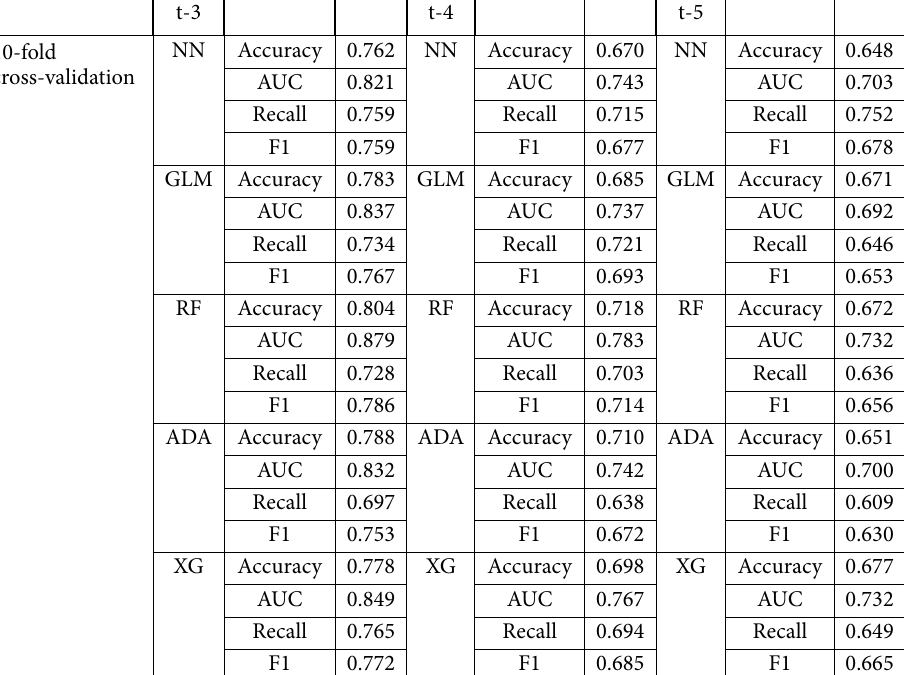
Table 7. Experimental results of different methods (Positive companies) t-3 t-4 t-5 10-fold